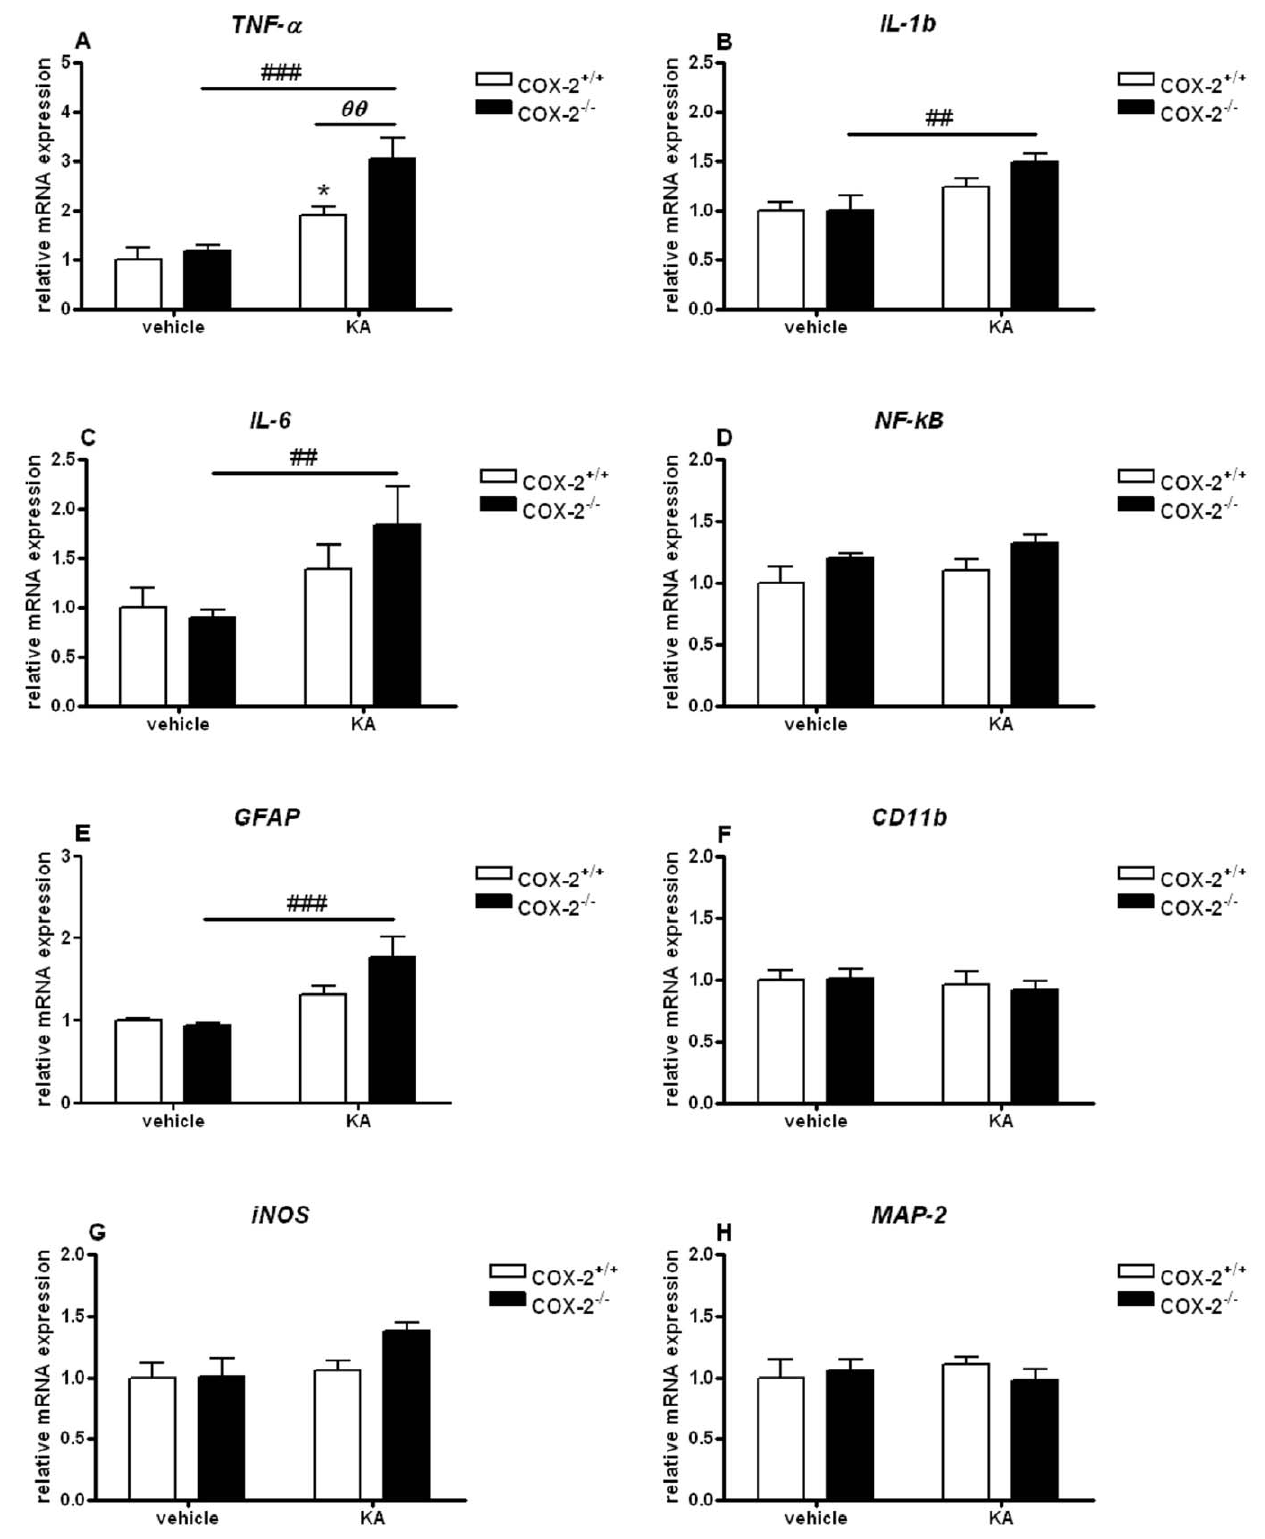
Figure 12. KA-induced expression of genes involved in the neuroinflammatory response in the cortex of COX-2 + / + and COX-2 2 / 2 mice. Quantitative real time-PCR analysis of TNF- a (A), IL-1 b (B), IL-6 (C), NF-kB (D), GFAP (E), CD11b (F), iNOS (G), MAP-2 (H) for COX-2 + / + and COX-2 2 / 2 mice 24 h after i.p. injection of KA or vehicle. Data are means 6 SEM ( n =9). Statistical analysis was performed using a two-way ANOVA and Bonferroni’s post-hoc test to compare replicate means. *P , 0.05, **P , 0.01, *** P , 0.001 compared to vehicle-injected COX-2 + / + mice; # P , 0.05, ## P , 0.01, ### P , 0.001, compared to vehicle-injected COX-2 2 / 2 mice; fi P , 0.05, fifi P , 0.01, fififi P , 0.001 between KA-injected COX-2 2 / 2 and KA-injected WT mice.